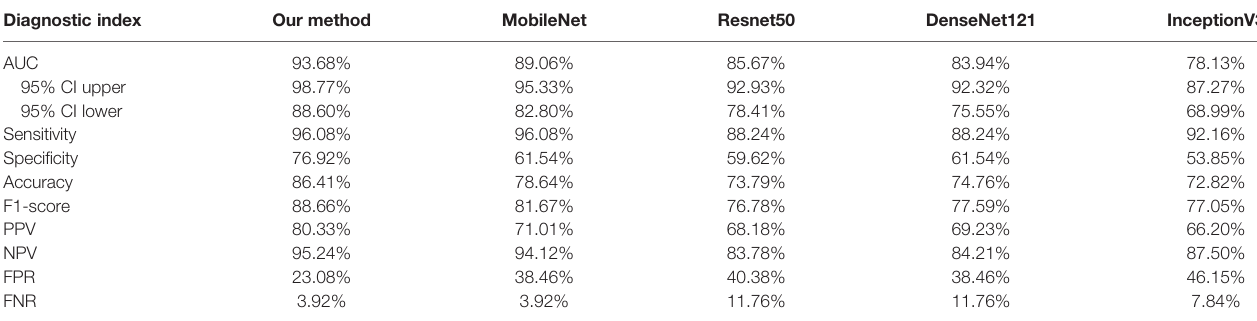
TABLE 2 | Diagnostic performance of all deep learning models in the test